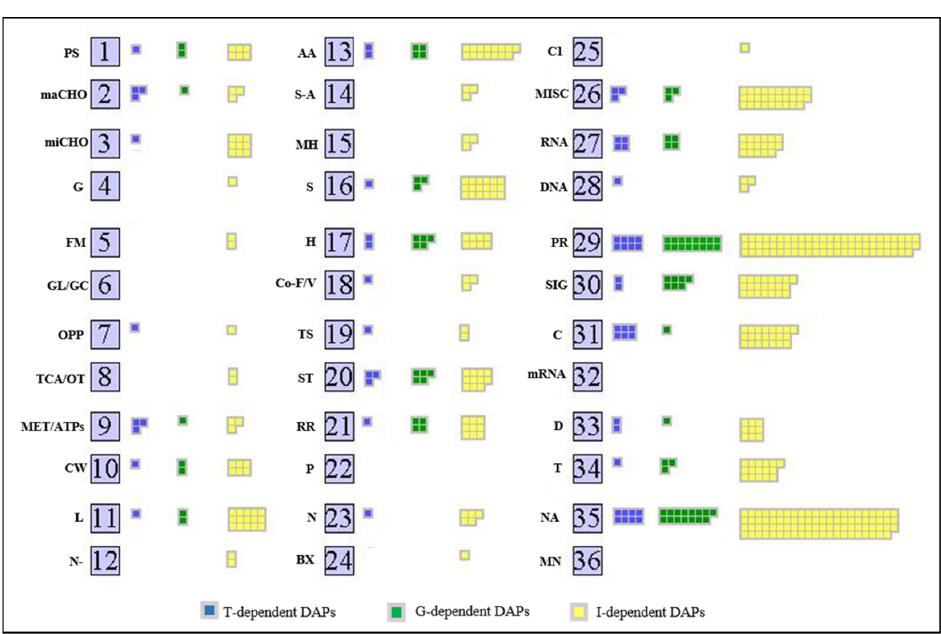
Figure 3. Functional classification of genotype (green squares, G), treatment (blue squares, T) and interaction-dependent (yellow squares, I) differentially accumulated proteins (DAPs) by MapMan Overview map. Each square represents a protein; The 36 BINS abbreviations: PS, photosynthesis; maCHO, major carbohydrate metabolism; miCHO, minor carbohydrate metabolism; G, glycolysis; FM, fermentation; GL/GC, gluconeogenesis/glyoxylate cycle; OPP, oxidative pentose phosphate; TCA/OT, tricarboxylic acid/organic acid transformations; MET/ATPs, mitochondrial electron trans- port/adenosine triphosphate; CW, cell wall; L, lipid metabolism; N-, nitrogen metabolism; AA, amino acid metabolism; S-A, sulphur assimilation; MH, metal handling; S, secondary metabolism; H, hor- mone metabolism; Co-F/V, co-factor and vitamin metabolism; TS, tetrapyrrole synthesis; ST, stress; RR, redox regulation; P, polyamine metabolism; N, nucleotide metabolism; BioDX, biodegradation of xenobiotics; C1, C1-metabolism; MISC, miscellaneous; RNA, ribonucleic acid; DNA, deoxyribonucleic acid; PR, protein; SIG, signalling; C, cell; mRNA, messenger RNA; D, development; T, transport; NA, not assigned; MN, mineral